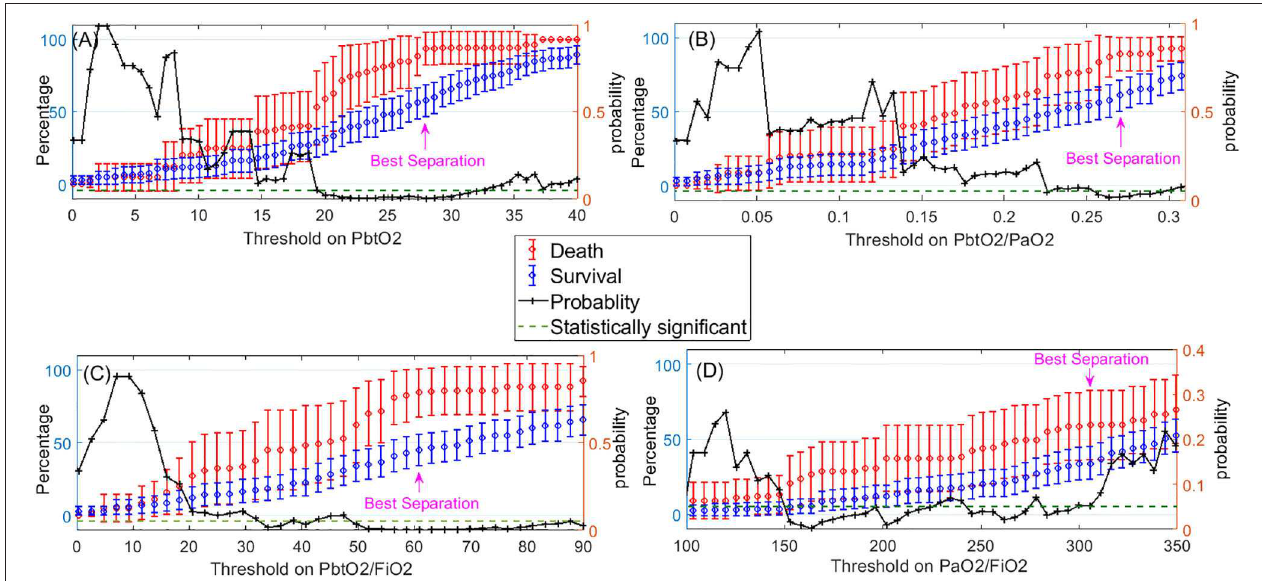
FIGURE 4 | Left-side vertical axis shows the average and 95% confidence interval for the percentages of compromised episodes of a variable (when the variable < Threshold) for two groups of patients: those who died (in red) and those who survived (in blue). The right-side vertical axis indicates the probability of the t -test that percentage of compromised episodes is significantly different between those who died and survived. The dashed green line represents the probability significance level of 0.05. So, whenever probability of the t -test (in black) is below the dashed green line, difference between death and survival is statistically significant. The pink arrow displays where the best separation between the death and survival outcomes is achieved. This point can be used to obtain the optimal threshold value on each of the following variables to indicate a hypoxic episode: (A) PbtO2, (B) PbtO2/PaO2, (C) PbtO2/FiO2, (D)